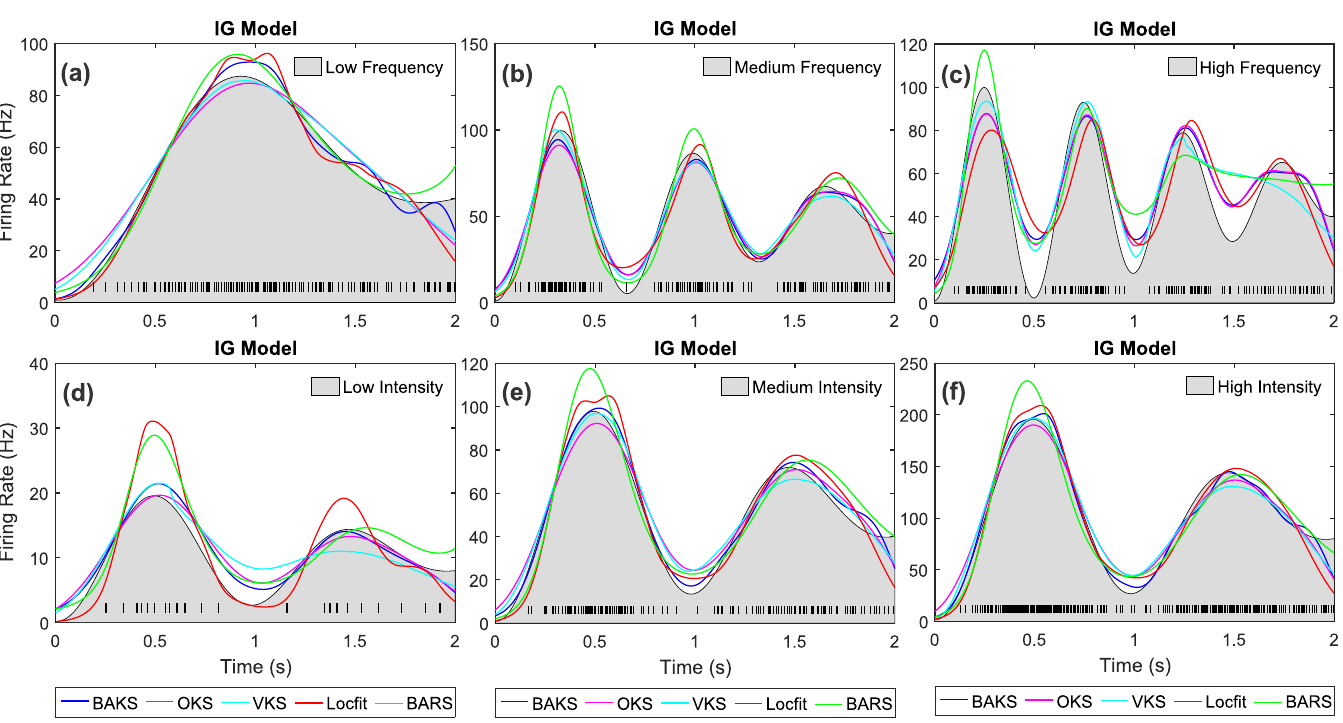
Fig 10. Firing rate estimate comparison for IG model with Gaussian-damped sinusoidal rate function. (a)-(c) Firing rate estimates for the cases of low, medium and high frequency, respectively. (d)-(f) Firing rate estimates for the cases of low, medium and high intensity, respectively. Black lines with gray-shaded regions indicate the underlying rate functions. Black raster in the bottom of each plot represents a spike train generated from the associated underlying rate function.